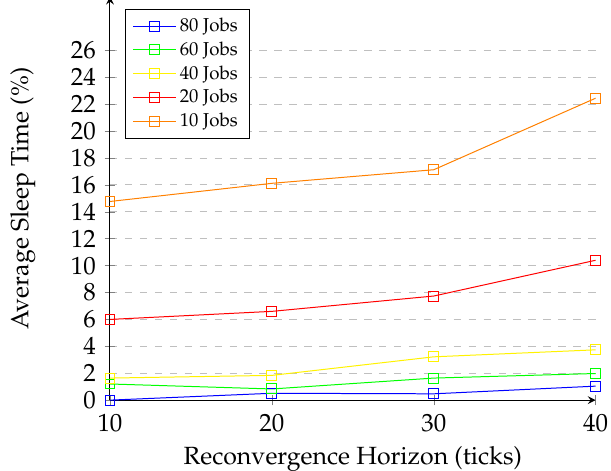
Figure 13. Average sleep time generation for 10 slack